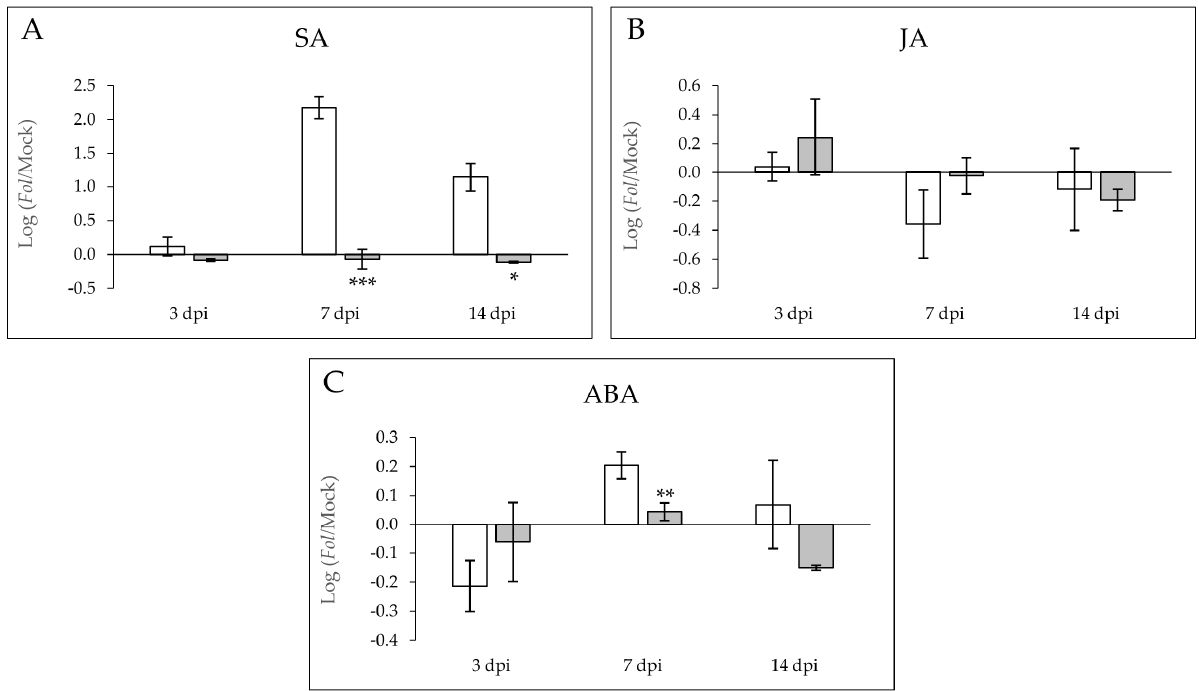
Figure 3. Logarithm of the ratios of the SA ( A ), JA ( B ) and ABA ( C ) phytohormone levels in susceptible Momor (MOM; white) and resistant Movione (MOV; gray) tomato plants upon Fusarium oxysporum f. sp. lycopersici inoculation at 3, 7 and 14 dpi, with respect to the corresponding mock-inoculated plants. Values were expressed as the average log(ratio) of data corresponding to a representative experiment. Asterisks (*) point out statistical differences according to t -test or a Mann–Whitney test, with p < 0.05 (*), p < 0.01 (**) and p < 0.001 (***).